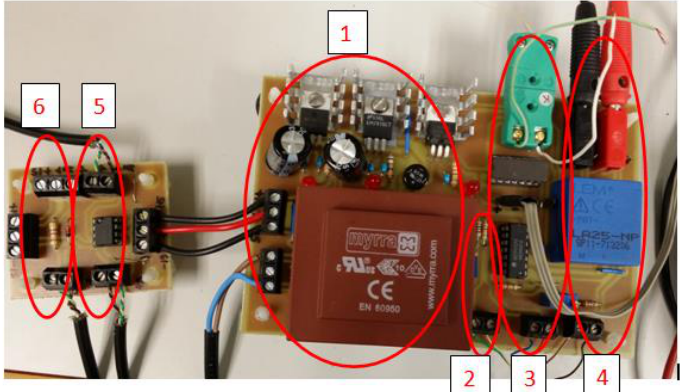
Figure 4. Image of the two interface cards. 1, power supply; 2, conditioning of the ambient temperature sensor; 3, conditioning of the cell temperature sensor; 4, conditioning of the current measuring; 5, cell voltage conditioning; 6, conditioning of pulses from the methanol flow meter.